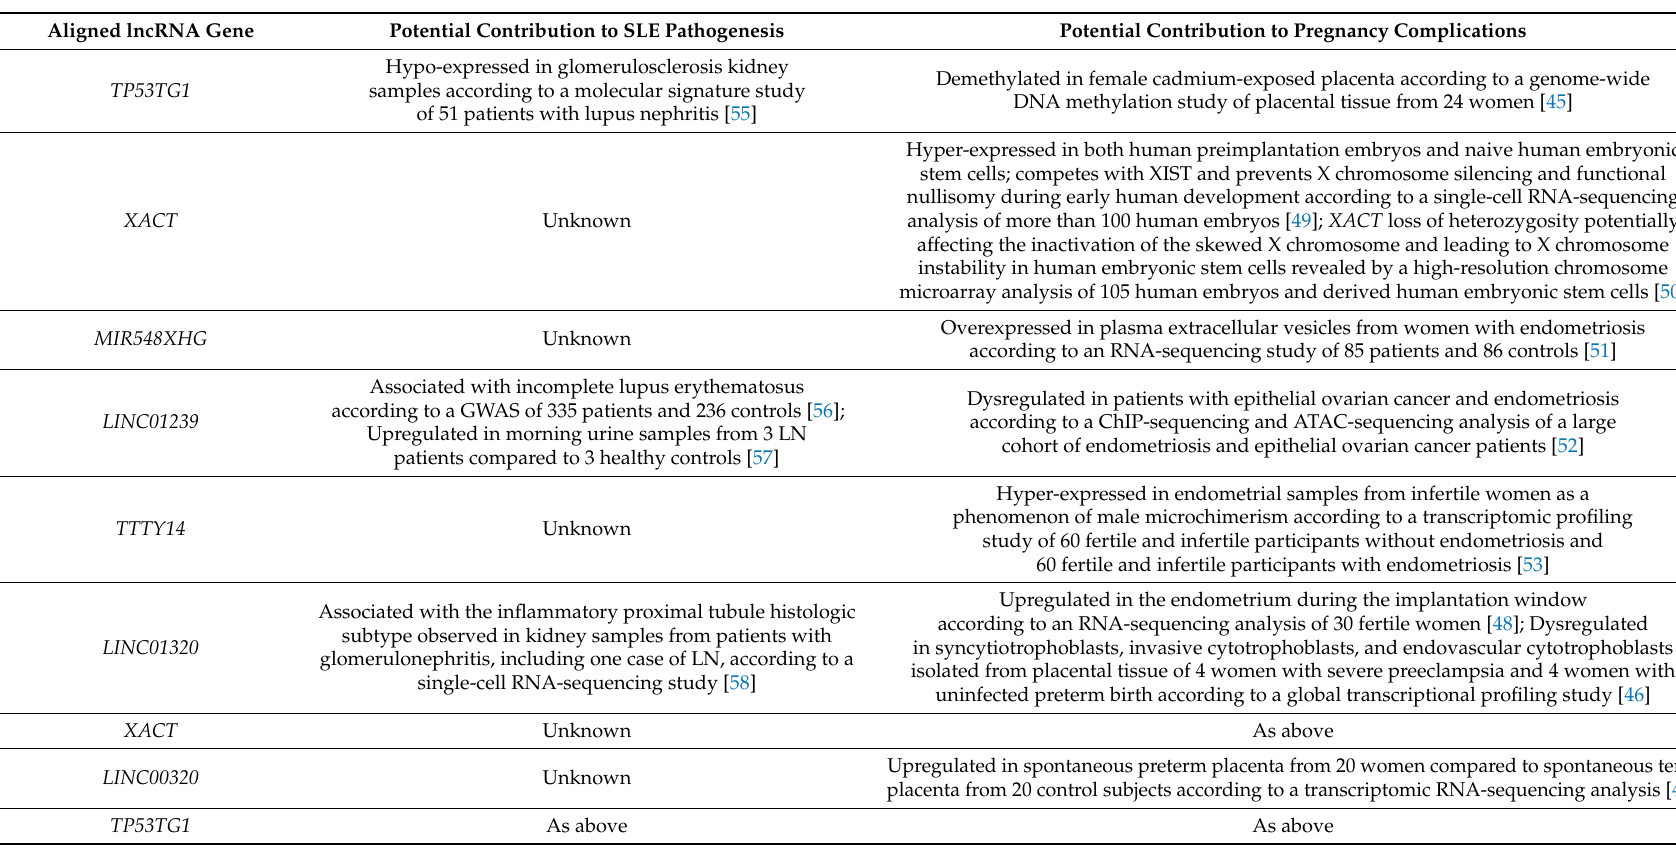
Table 5. Summary of literature data showing a possible role of lncRNAs aligning with the nucleotide sequence of syncytin-1 and syncytin-2 in the pathogenesis of SLE or pregnancy complications (GWAS: genome-wide association study; LN: lupus